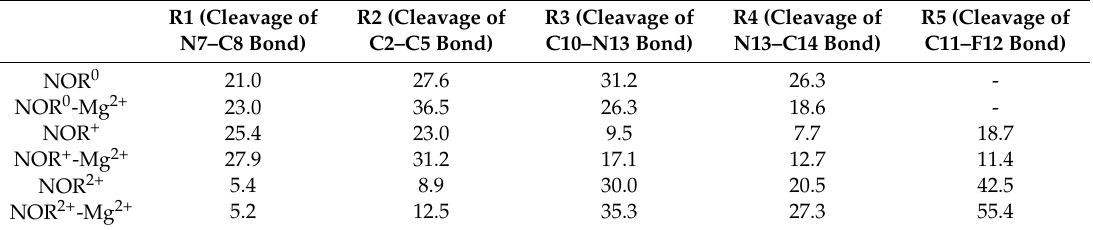
(R1, R2, R3, R4, and R5) of three dissociation forms of NOR and complexes with Mg 2+